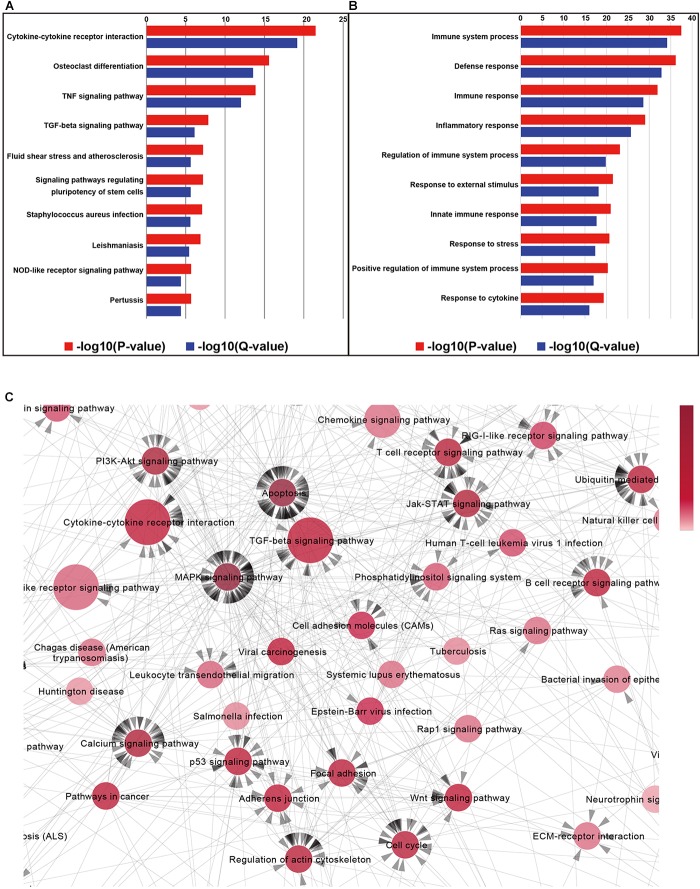
Column charts of the Gene Ontology (GO) and pathway enrichment analyses of differentially expressed genes in the retina of metformin-treated rd1 mice at P14. (A) The 10 most significant biological processes in the GO enrichment analyses. P-values and Q-values represent the level of significance of enrichment. (B) The 10 most significant pathways in the Kyoto Encyclopedia of Genes and Genomes (KEGG) pathway enrichment analyses. (C) Partial enlargement of the pathway-act-network analysis of the retina in metformin-treated and PBS-treated rd1 mice at P14. A pathway-act-network was constructed according to the interactions within pathways identified in the KEGG database. Each node (red circle) represents a signaling pathway. Arrows represent interactive relationships between two signaling pathways. We used the size of the circle to represent the significance of the difference between the groups in the KEGG pathway. The circular red shades represent the clustering coefficients. A darker color indicates more strongly associated pathways. The direction of the arrow represents the upstream and downstream relationship of the path.